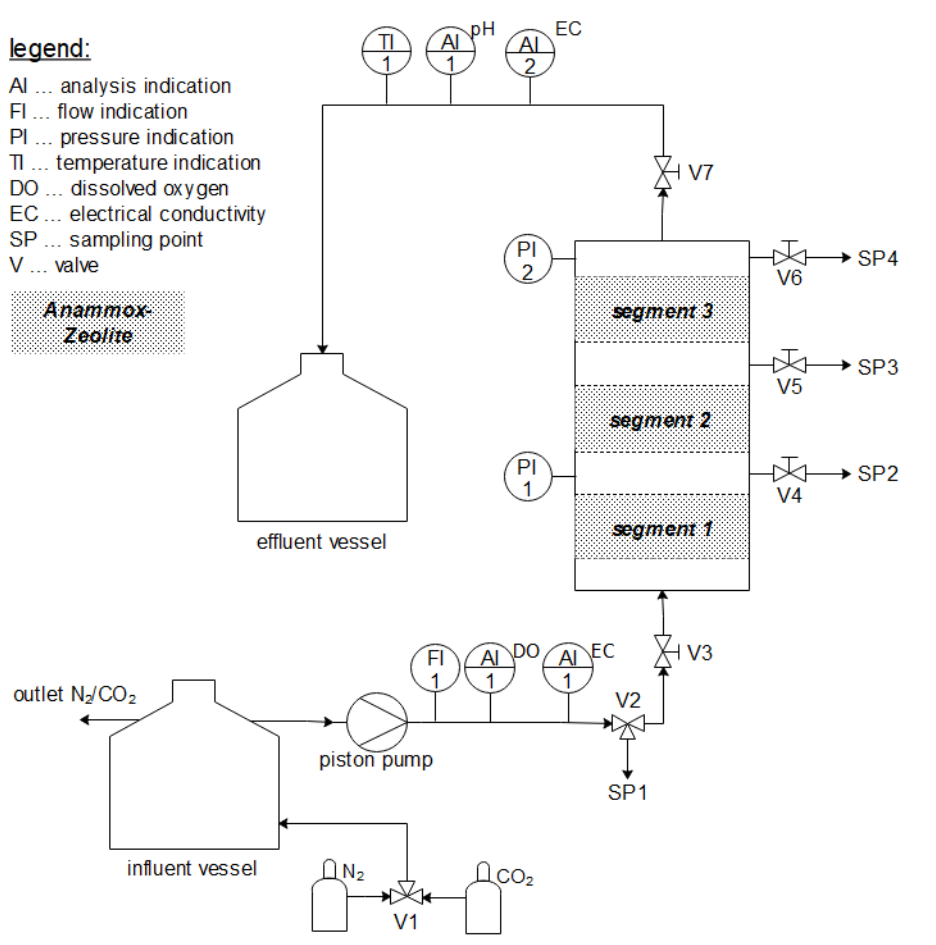
Figure 1. Flowchart of the Laboratory Setup. Table 2. Specifications of the used Anammox zeolite-biofilter.